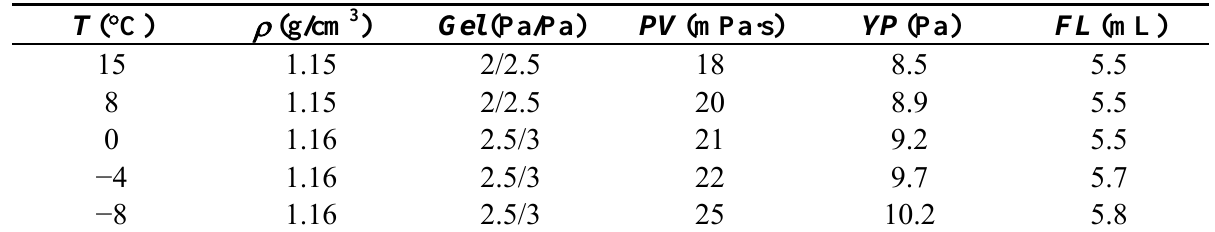
Table 2. The rheological properties of polyethylene-glycol drilling fluid at different temperatures.